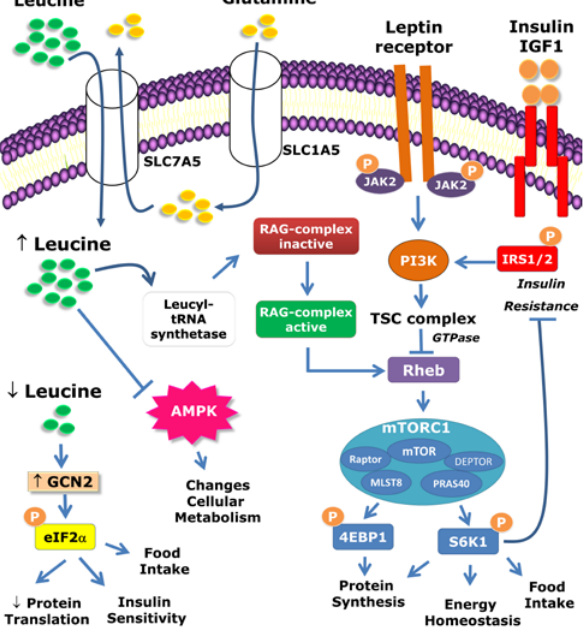
Figure 1. Intracellular mechanisms activated by leucine. The mammalian target